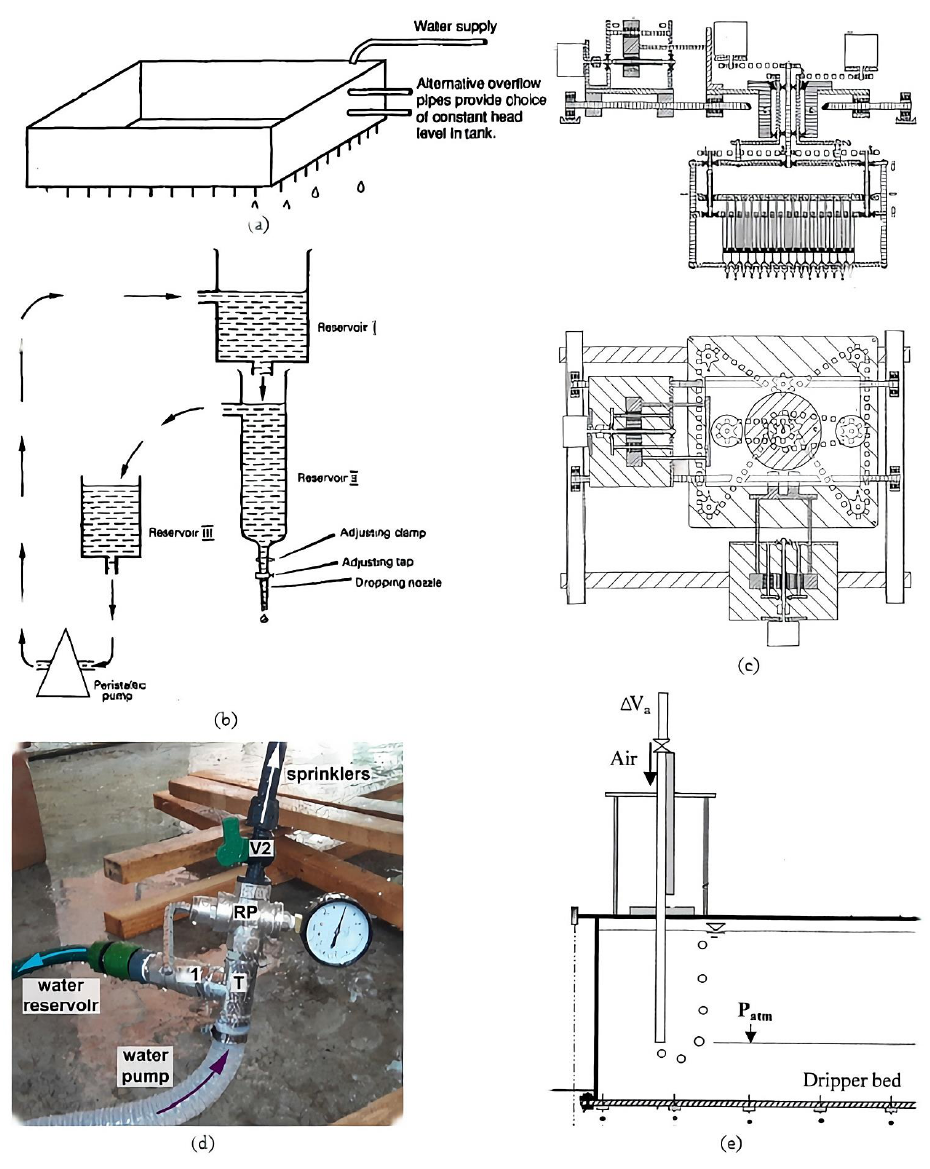
Figure 3. Different water flow regulating mechanisms: ( a ) Pump flow control and water level maintenance in the water tank with drippers [82] (Reprinted/adapted with permission from Ref. [Terry & Shakesby, 1993]); ( b ) Flow control by pump, maintenance of water level in the water tank with drippers and adjustable valves [83] (Reprinted/adapted with permission from Ref. [Cousen & Farres, 1984]); ( c ) Specific mechanism of flow control and simulator operation [73] (Re- printed/adapted with permission from Ref. [Römkens et al., 1975]); ( d ) Mechanism in the form of